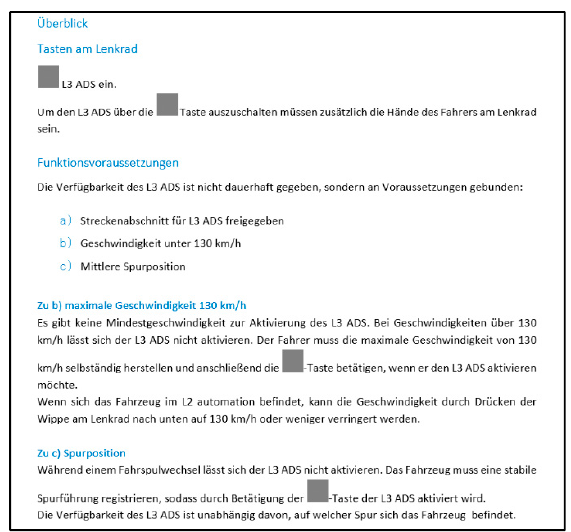
Figure 2. Excerpt from owner’s manual. Note that icons had been disguised due to confidentiality and are represented as black squares. Specific function names have been replaced by “ L3 ADS ” and “ L2 automation ”.